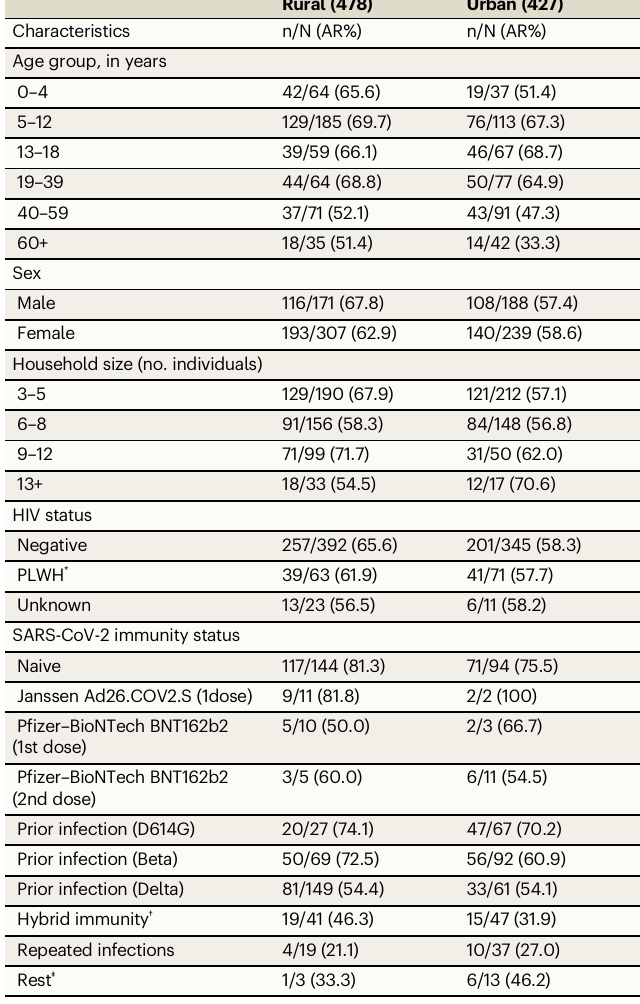
Table 1 | Omicron BA.1/2 infection attack rate (AR) in rural and urban cohorts of South Africa based on 905 participants with complete serologic information (75% of the total 1200